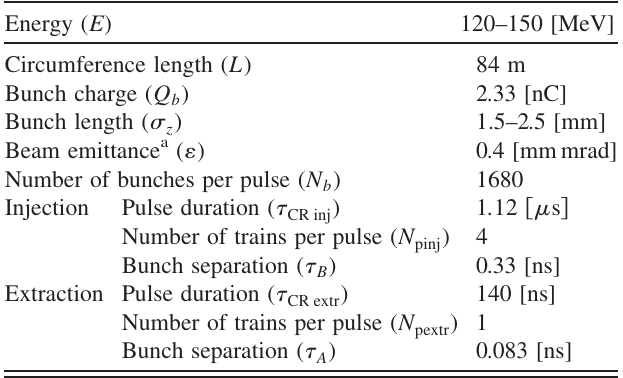
TABLE I. Main CTF3 parameters at the injection/extraction of the CR.